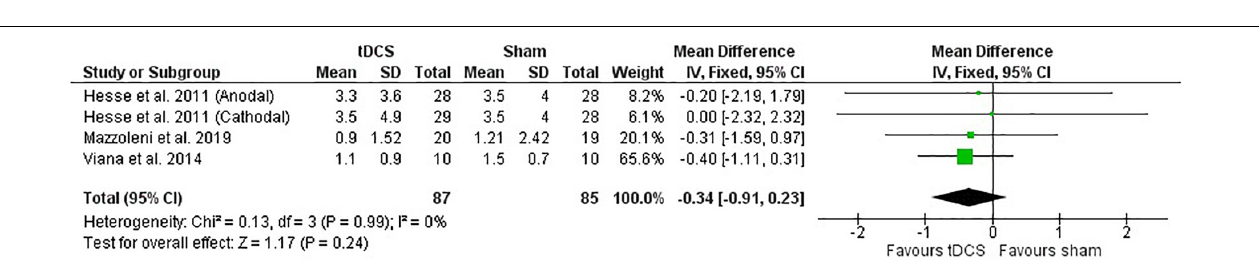
stimulation. The subgroup for the anodal stimulation involved 115 individuals (sham: 57 vs. tDCS: 58) and the subgroup for the cathodal stimulation involved 57 individuals (sham: 28 vs. tDCS: